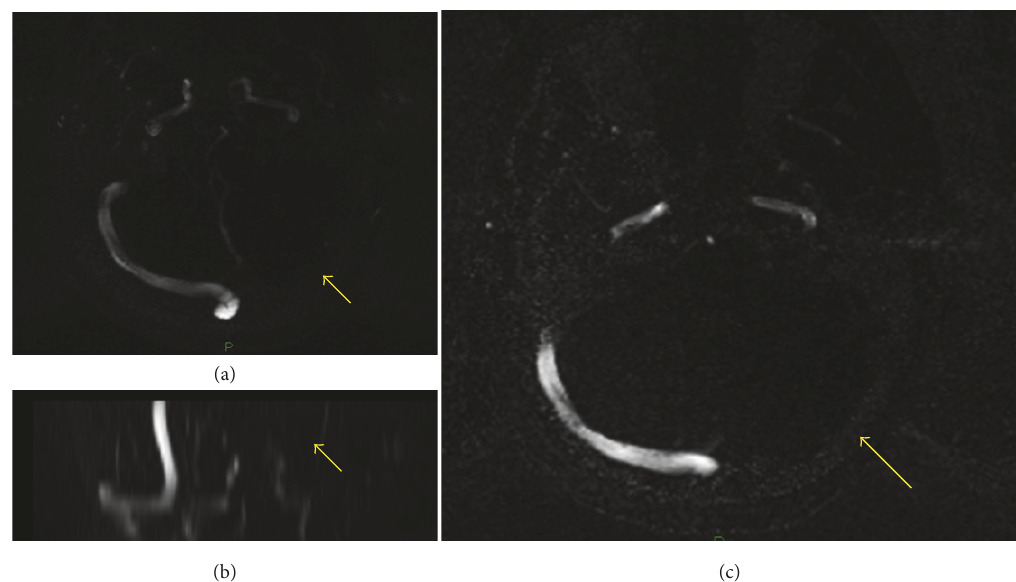
Figure 3: Loss of flow signal intensity in left lateral sinus which is showing heterogeneous appearance on FLAIR and T2-weighted images suggesting left lateral sinus thrombosis with venous